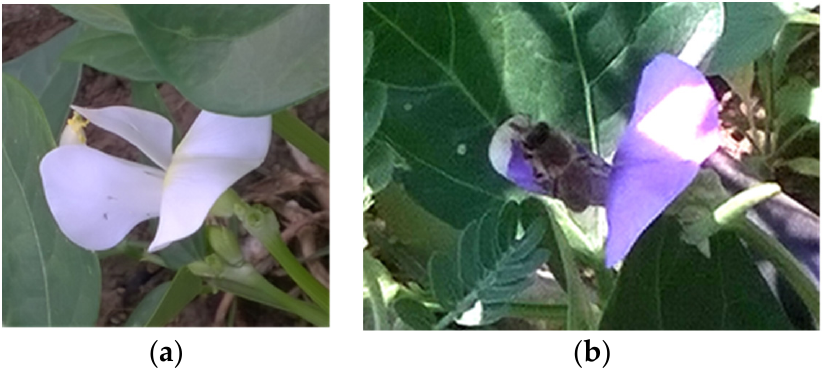
Figure 5. ( a ) Flower with exposed anthers and stigma; ( b ) Apis mellifera bee foraging in a previously exposed flower.